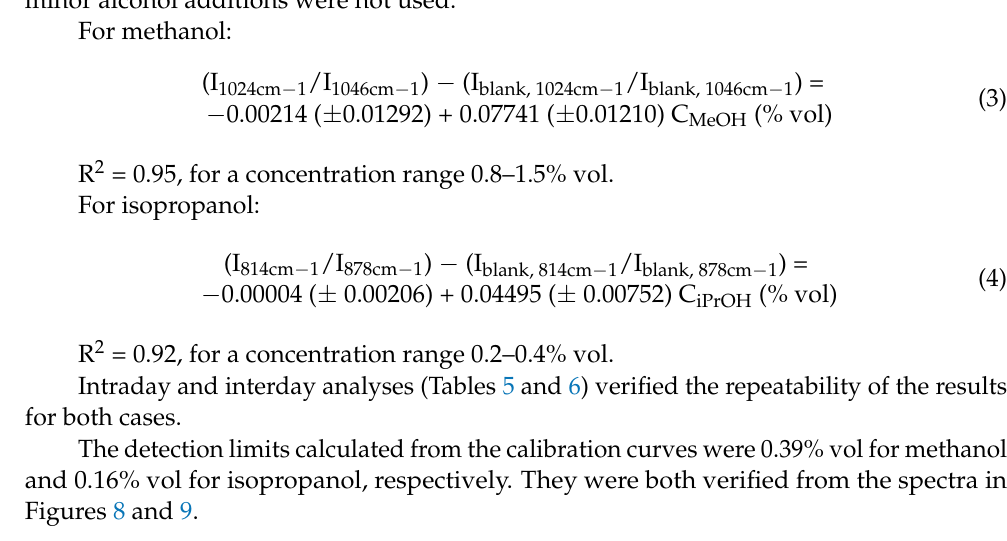
Figure 9. ( A ) Raman spectra of increasing concentrations of isopropanol (0–0.40% vol) added to Ballantine’s whiskey. The peak of isopropanol appears at 814 cm −1 . The spectra quoted are normalized to the 878 cm −1 peak of ethanol. ( B ) Magnified spectral area 790–840 cm −1 of ( A ). The spectra are baselined. Isopropanol presence can be verified for content 0.10% vol or higher. ( C ) Raman spectrum of isopropanol.